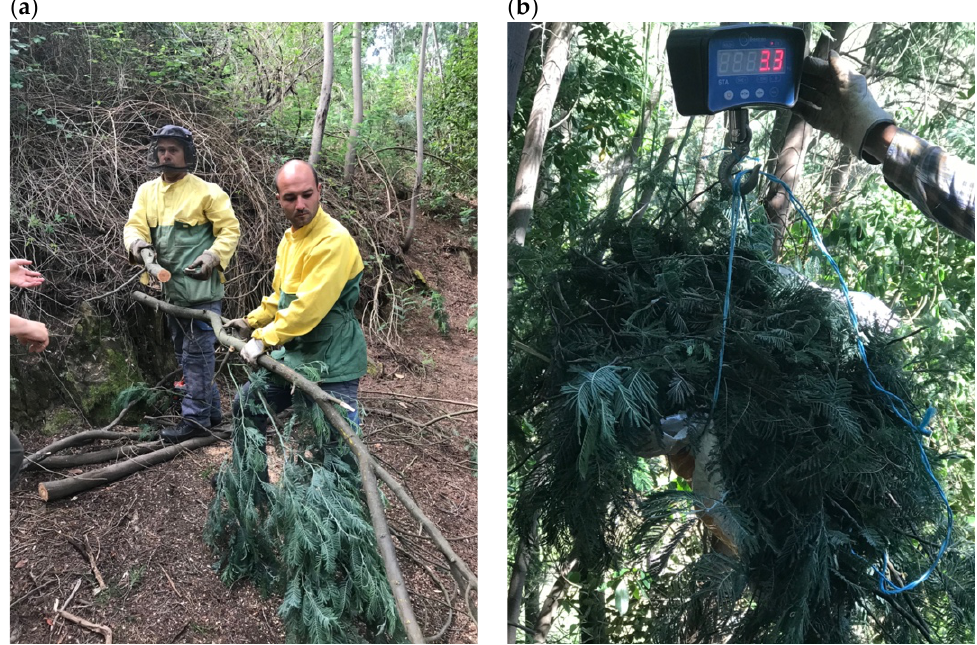
Figure 3. Steps in the process of sampling with ( a ) cutting and measuring the A. dealbata trees and ( b ) weighing the selected specimens.